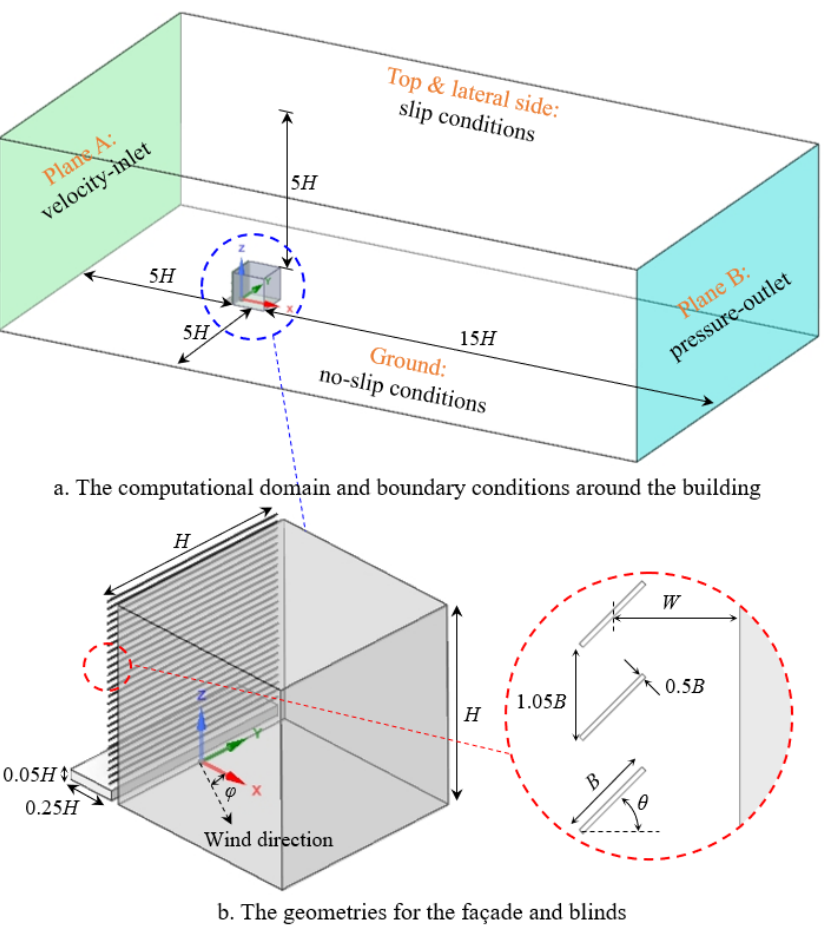
Figure 3. Computational domain and boundary conditions for validations.